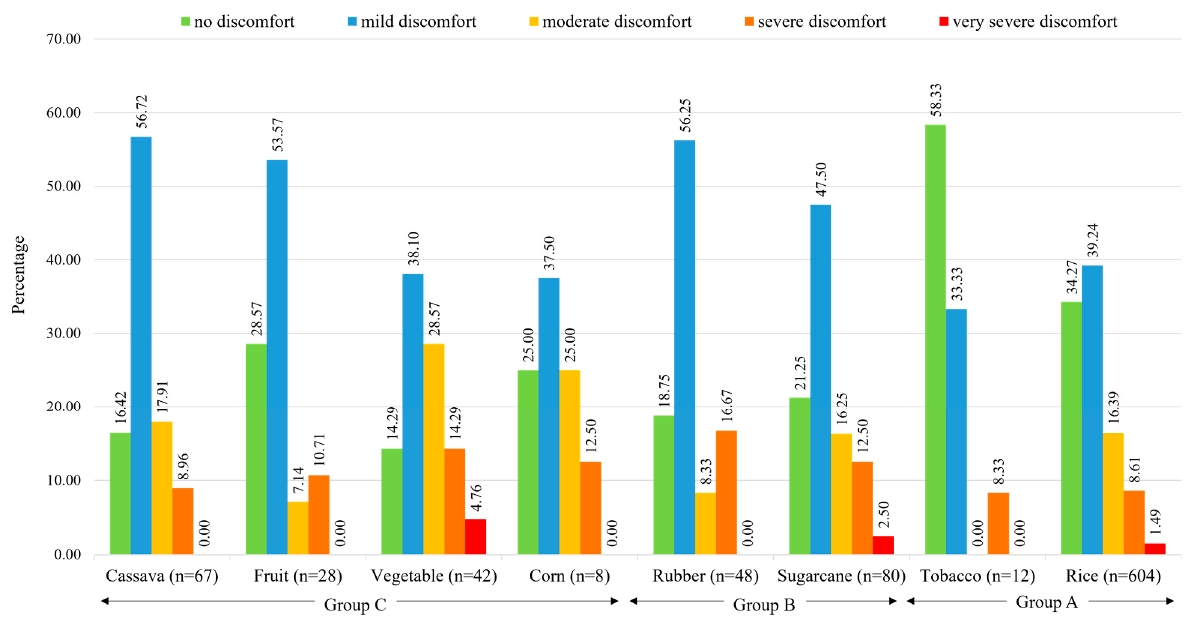
Figure 3. Musculoskeletal discomfort levels classified according to group and cultivating type.